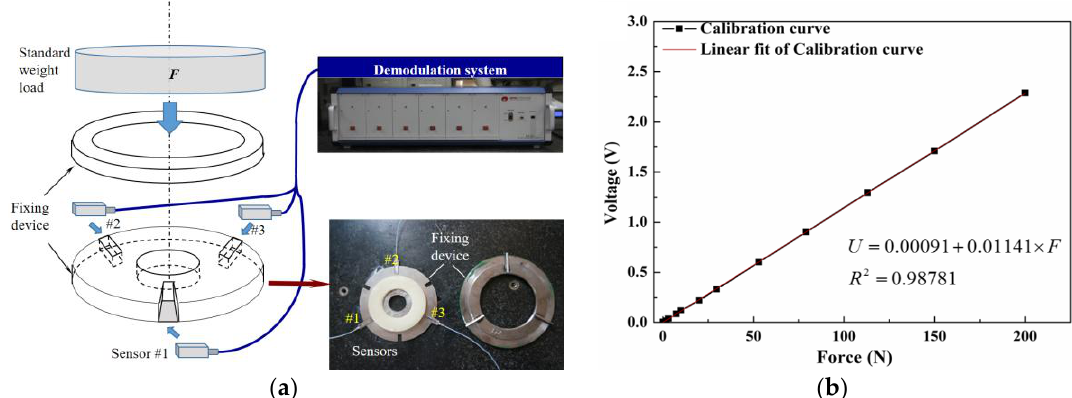
Figure 6. ( a ) Schematic and image of sensors calibration fixture; ( b ) the calibration result and the fitting curve of voltage–force.